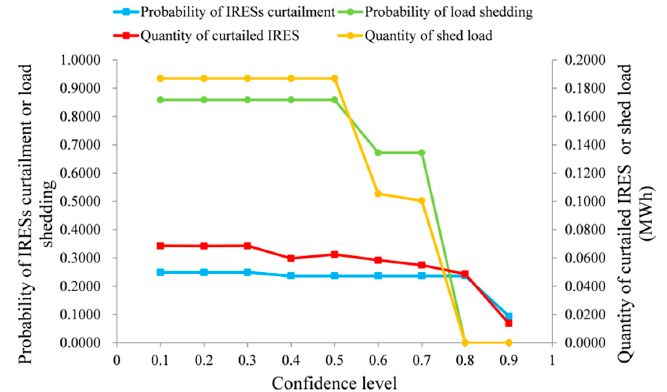
ff erent confidence level. Energies 2019 , 12 , x FOR PEER REVIEW